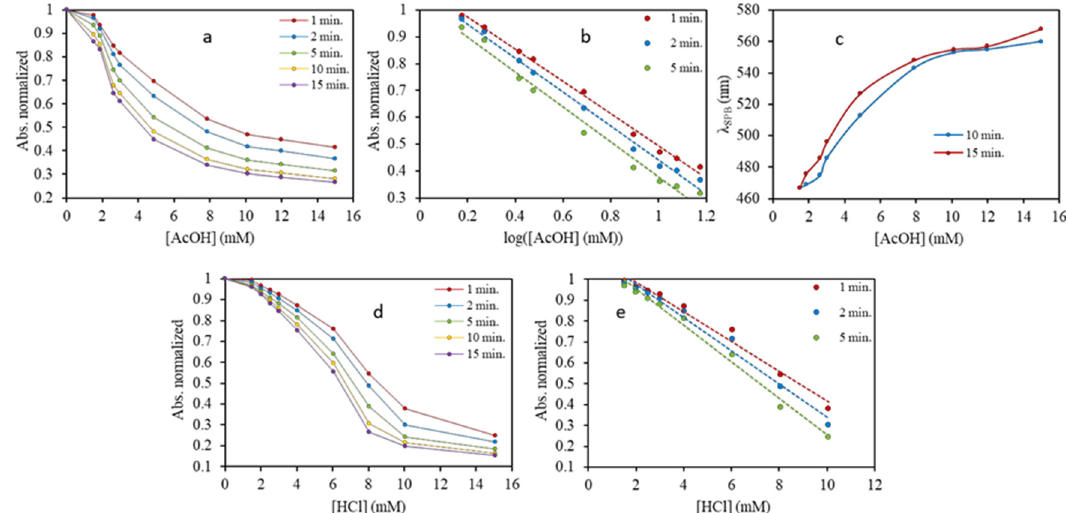
Figure 11. Normalized absorbance values at various times with the concentration of acetic acid ( a ), its log ( b ) of AgNPs diluted 1:4 (5 µg/mL) and evolution of the wavelength of the second plasmon maximum in the UV-Vis spectra at 10 and 15 min of its preparation ( c ). ( d , e ) correspond to the influence of hydrochloric acid.